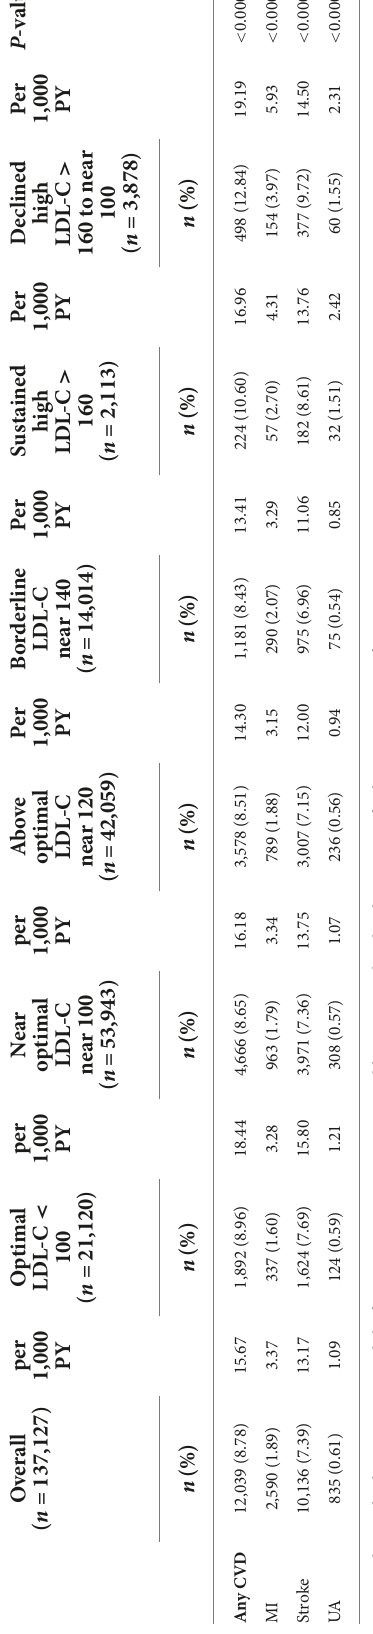
at < 100 mg/dL over time) ( Figure 2A and Supplementary Table 4 ). Overall, the association of the LDL-C trajectory with the risk of a CV event was stronger for MI than for stroke and unstable angina. Patients in the sustained high LDL-C trajectory